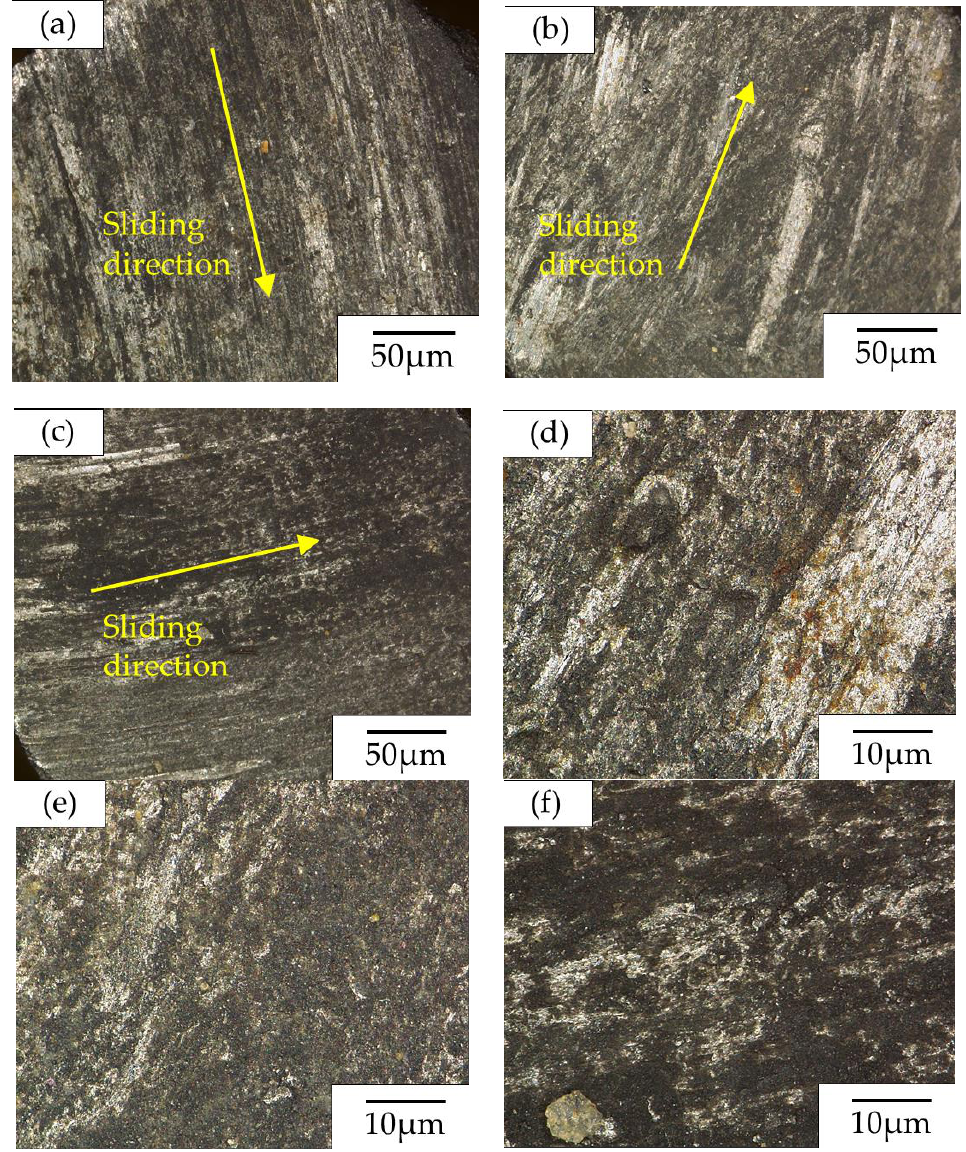
Figure 8. Micro morphologies of worn surfaces of the pin at different speeds (5 N, loam, moisture 0): ( a , d ) speed of 300 r/min; ( b , e ) speed of 400 r/min; ( c , f ) speed of 600 r/min.